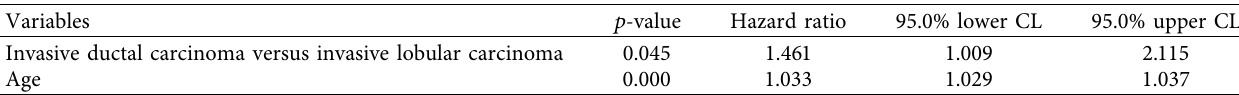
Table 11: Cox multivariable regression analysis of survival of two common breast cancer histological types in urban Shenyang from 2008 to 2013.